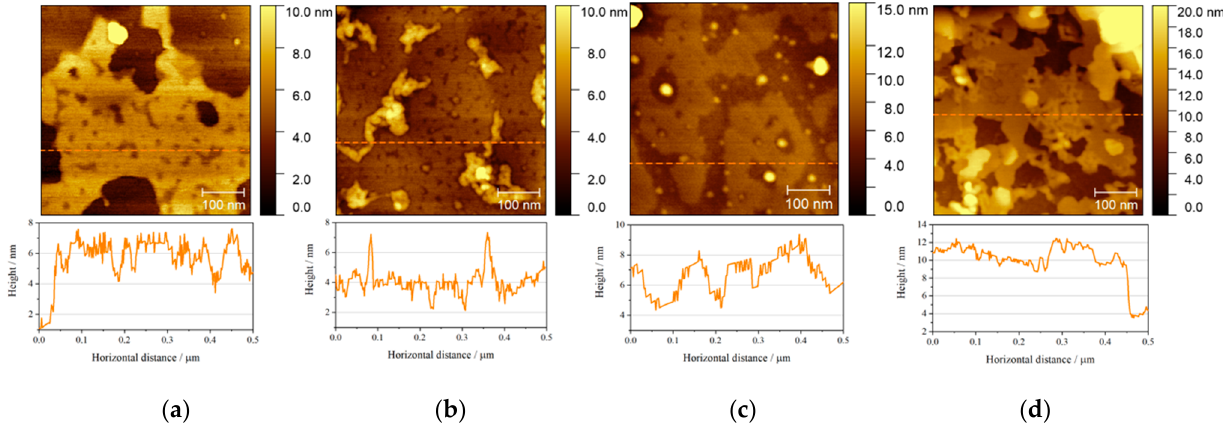
Figure 8. Upper panel: AFM images (500 × 500 nm 2 ) of lipid rafts models ( a ) DOPC:Chol:SM 1:1:2, ( b ) DOPC:Chol:SM 1:2:1, ( c ) DOPC:Chol:SM 2:1:1 and ( d ) DOPC:Chol:SM 1:1:1; Lower panel: vertical profiles corresponding to orange dashed lines in the above AFM images.